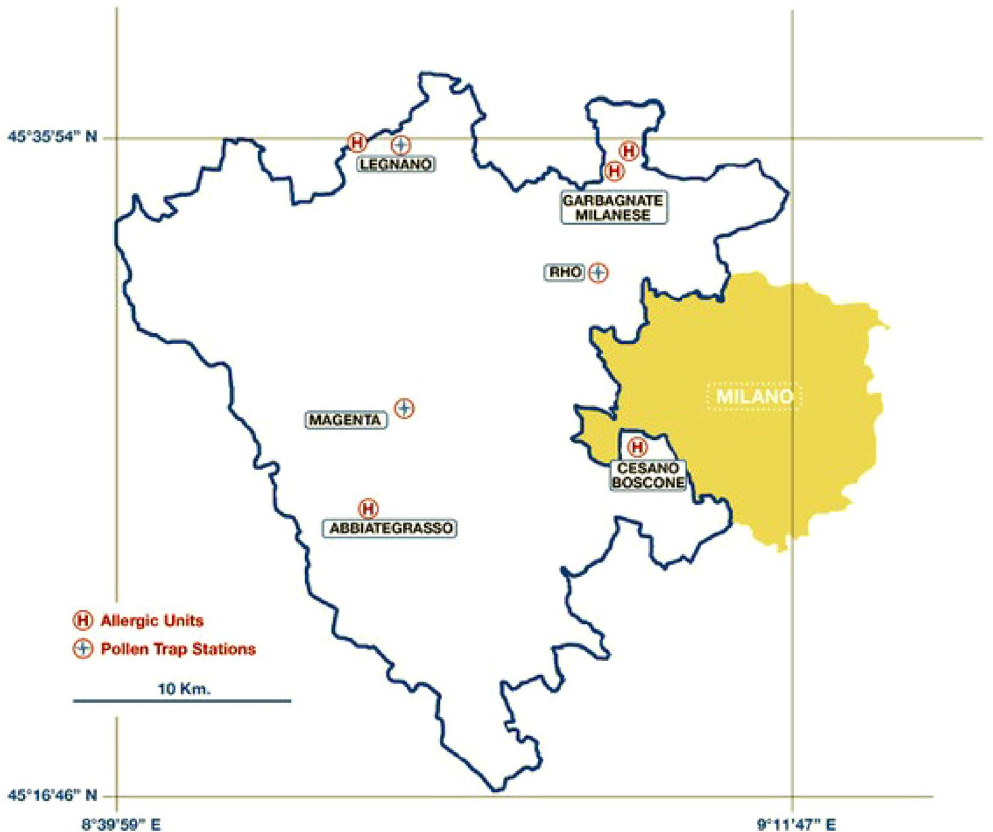
Figure 1. Map of the ASST Ovest Milanese and ASST Rhodense districts, included in the Agency for Health Protection of the Metropolitan Area of Milan (ATS); the ‘blue + ’ symbols represent the three Hirst volumetric traps, and the ‘red H’ symbol shows the location of the five allergy clinics (note: in Legnano there is both an Hirst volumetric trap and an allergy